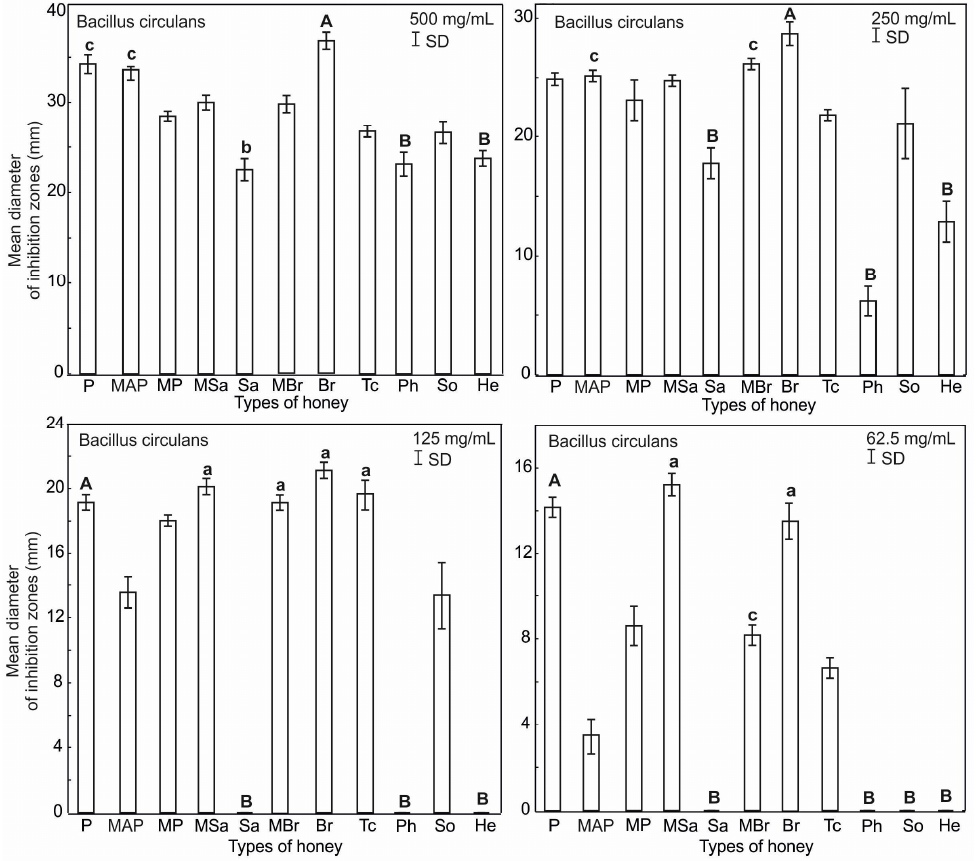
Figure 3. Results of the ANOVA Kruskal–Wallis H test for inhibition activity of all tested honey types and their concentrations against B. circulans . Statistical differences are marked with different letters and their significance at p ≤ 0.001 with capital letters, p ≤ 0.05 with lowercase letters.